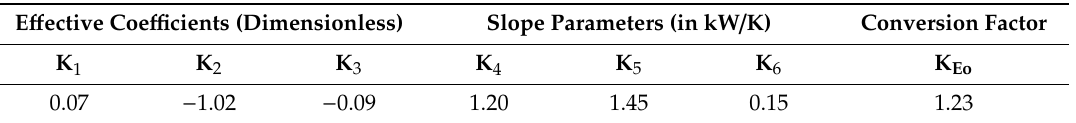
Table 3. Characteristic coe ffi cients of the absorption chiller at the Federal Environment Agency (UBA) in Dessau,